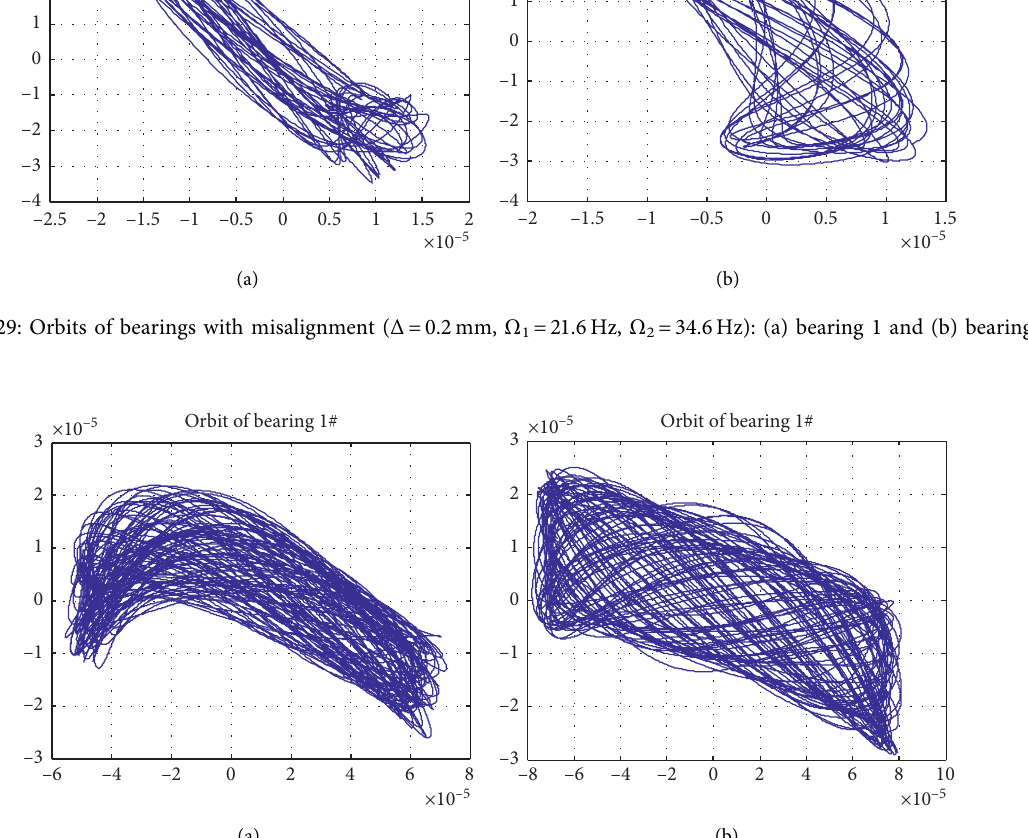
� 11.6Hz, Ω � 18.6Hz): (a) Δ � 0.2mm and (b) Δ � 0.4mm. 1 2